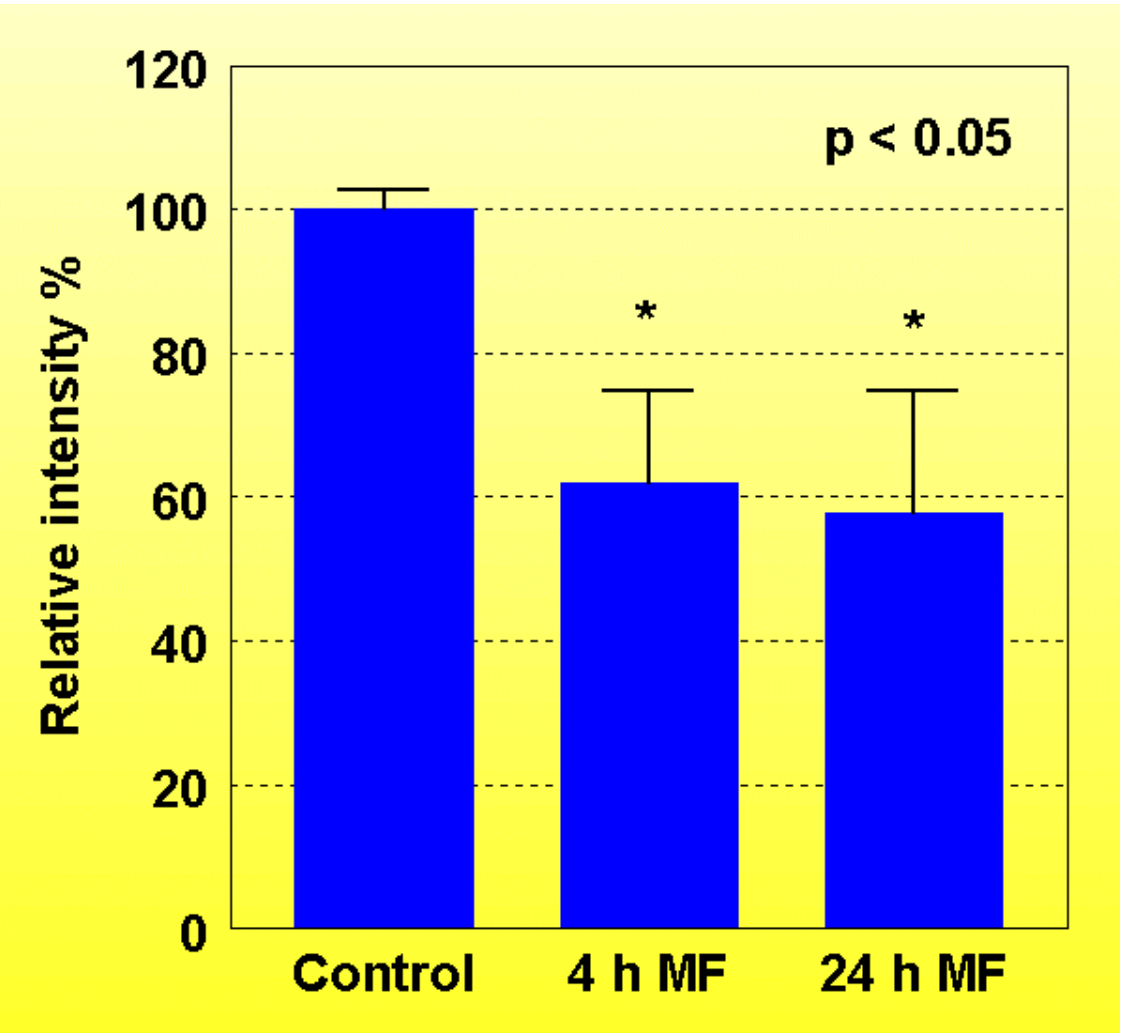
FIGURE 2 . The relative amounts of β -catenin in the control and MF-exposed